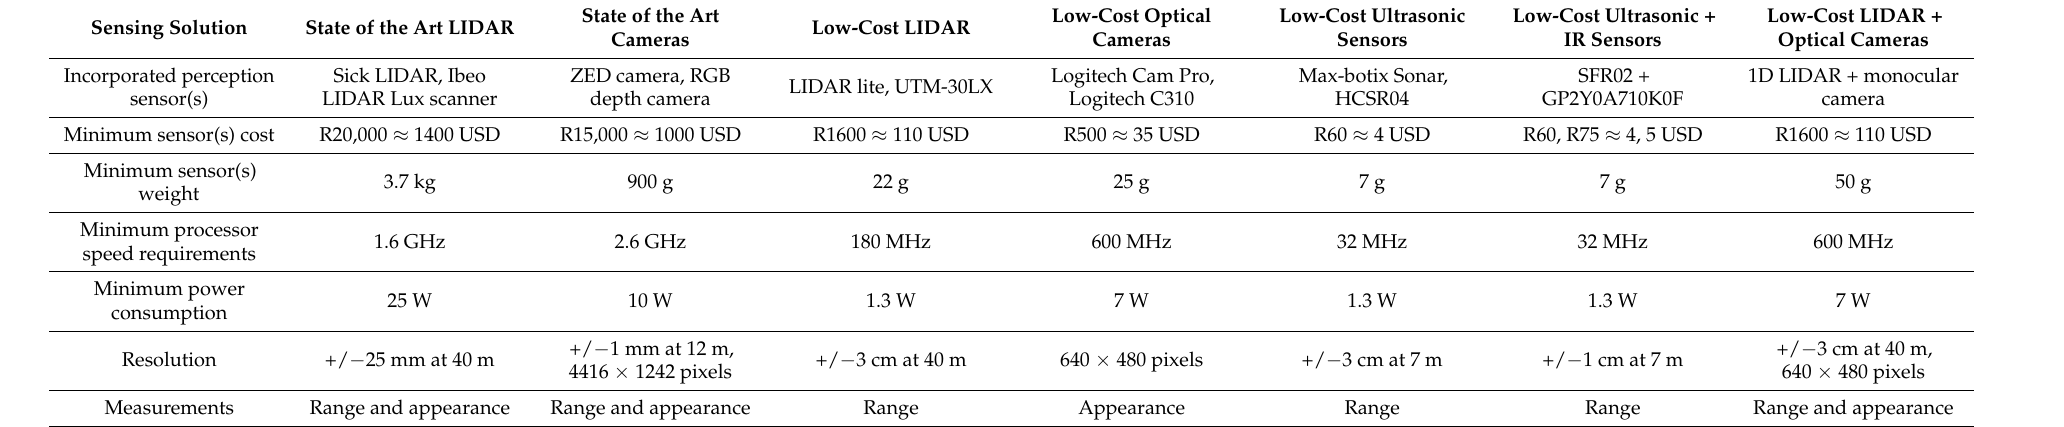
Table 1. Comparison of obstacle sensing solutions proposed in